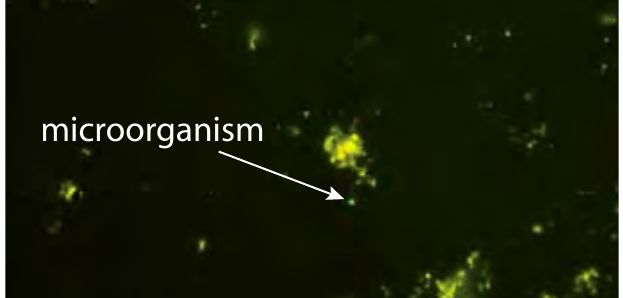
Figure 1. Microorganism from sediment deep beneath the Arctic seafloor (IODP Leg 302). The microbe glows because it has been stained with a fluorescent dye (SYBR Green) that preferentially binds to DNA. Photomi- crograph from David C.